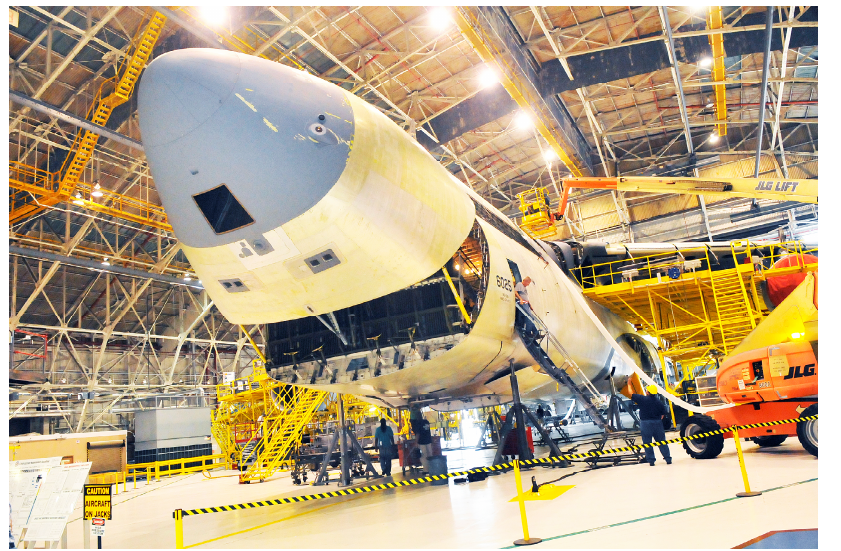
Figure 8 – The highest programmed level of the C–5 aircraft maintenance in RAFB Рис . 8 – Высший запрограммированный уровень содержания самолета C–5 в